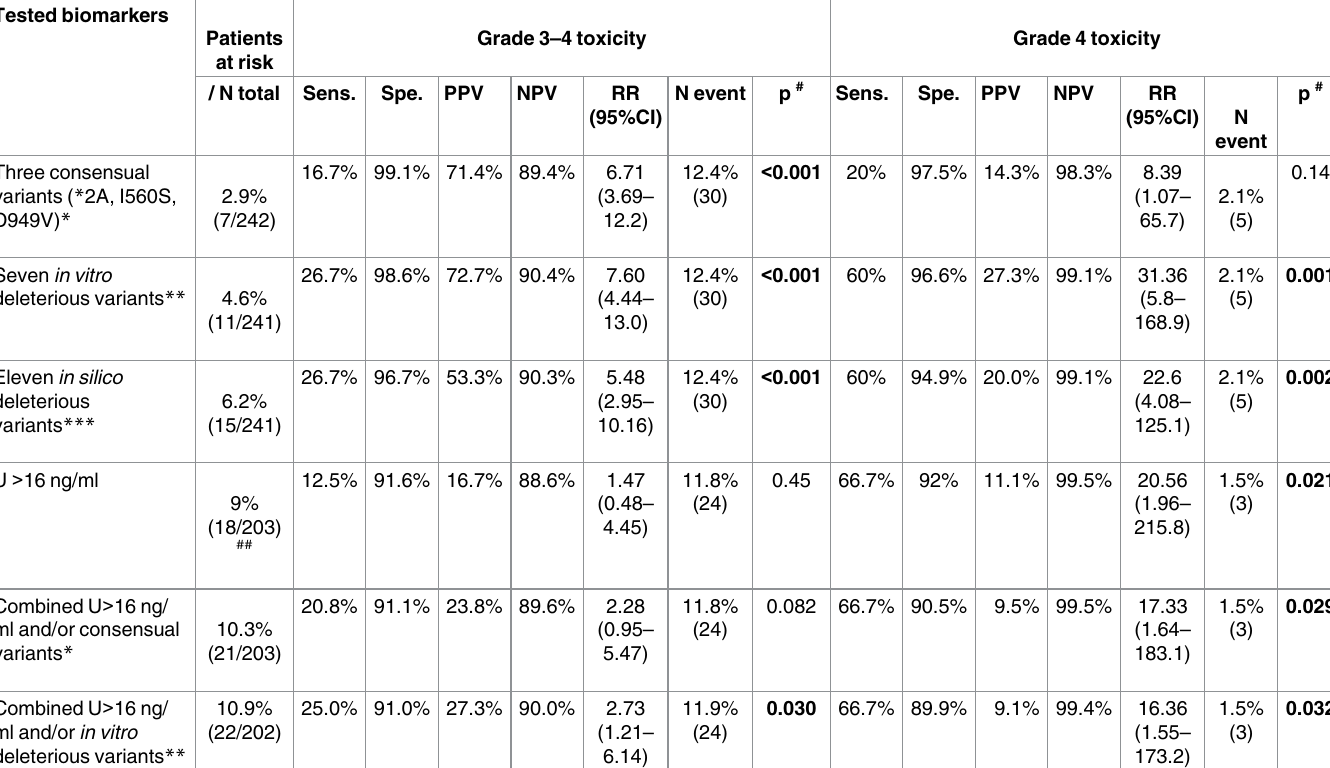
Table 4. Association of variant combinations and/or DPD phenotype with capecitabine-related toxicity (maximum toxicity grade considering hematotoxicity, digestive and neurotoxicity). Tested biomarkers Patients at